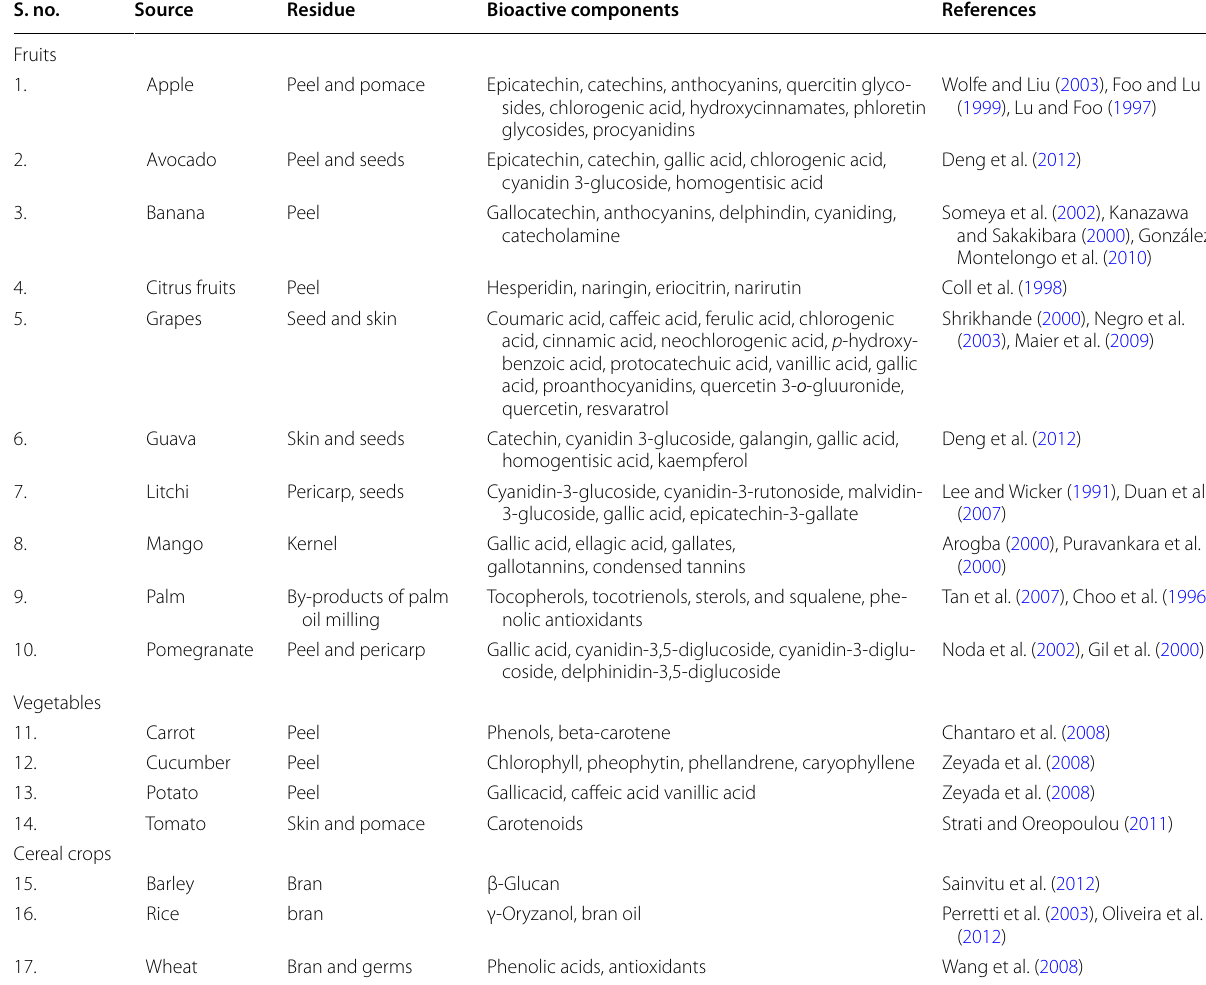
Table 1 Bioactive components in different industrial food waste residues S.